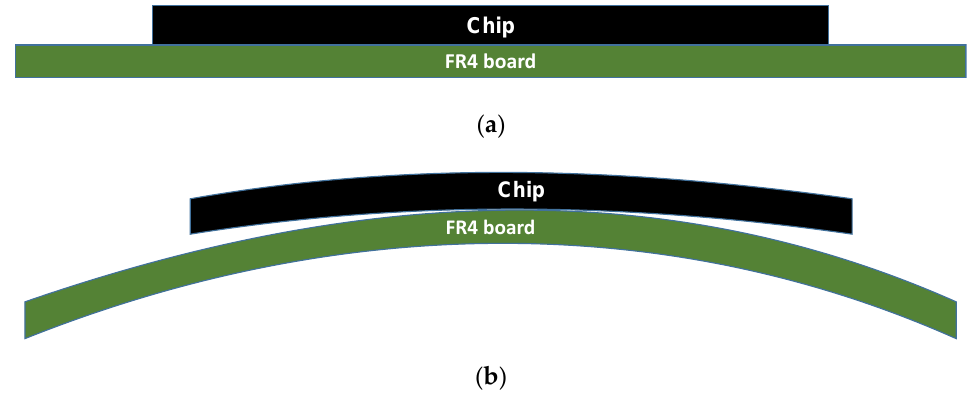
Figure 1. Printed wiring board (PWB) and chip deformation ( a ) at a processing temperature in stress-free conditions and ( b ) at room temperature after cooling.